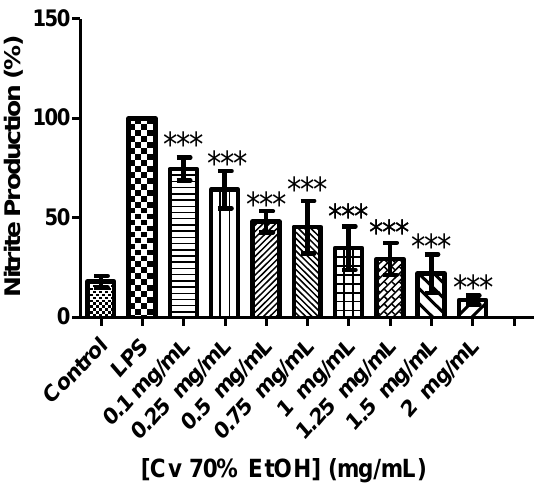
Figure 3. Effect of Crepis vesicaria subsp. taraxacifolia ethanolic extract on NO production in macrophages (RAW 264.7 cells). Each result represents the mean ± SD (minimum of three independent assays). *** p < 0.001 compared with the LPS group.